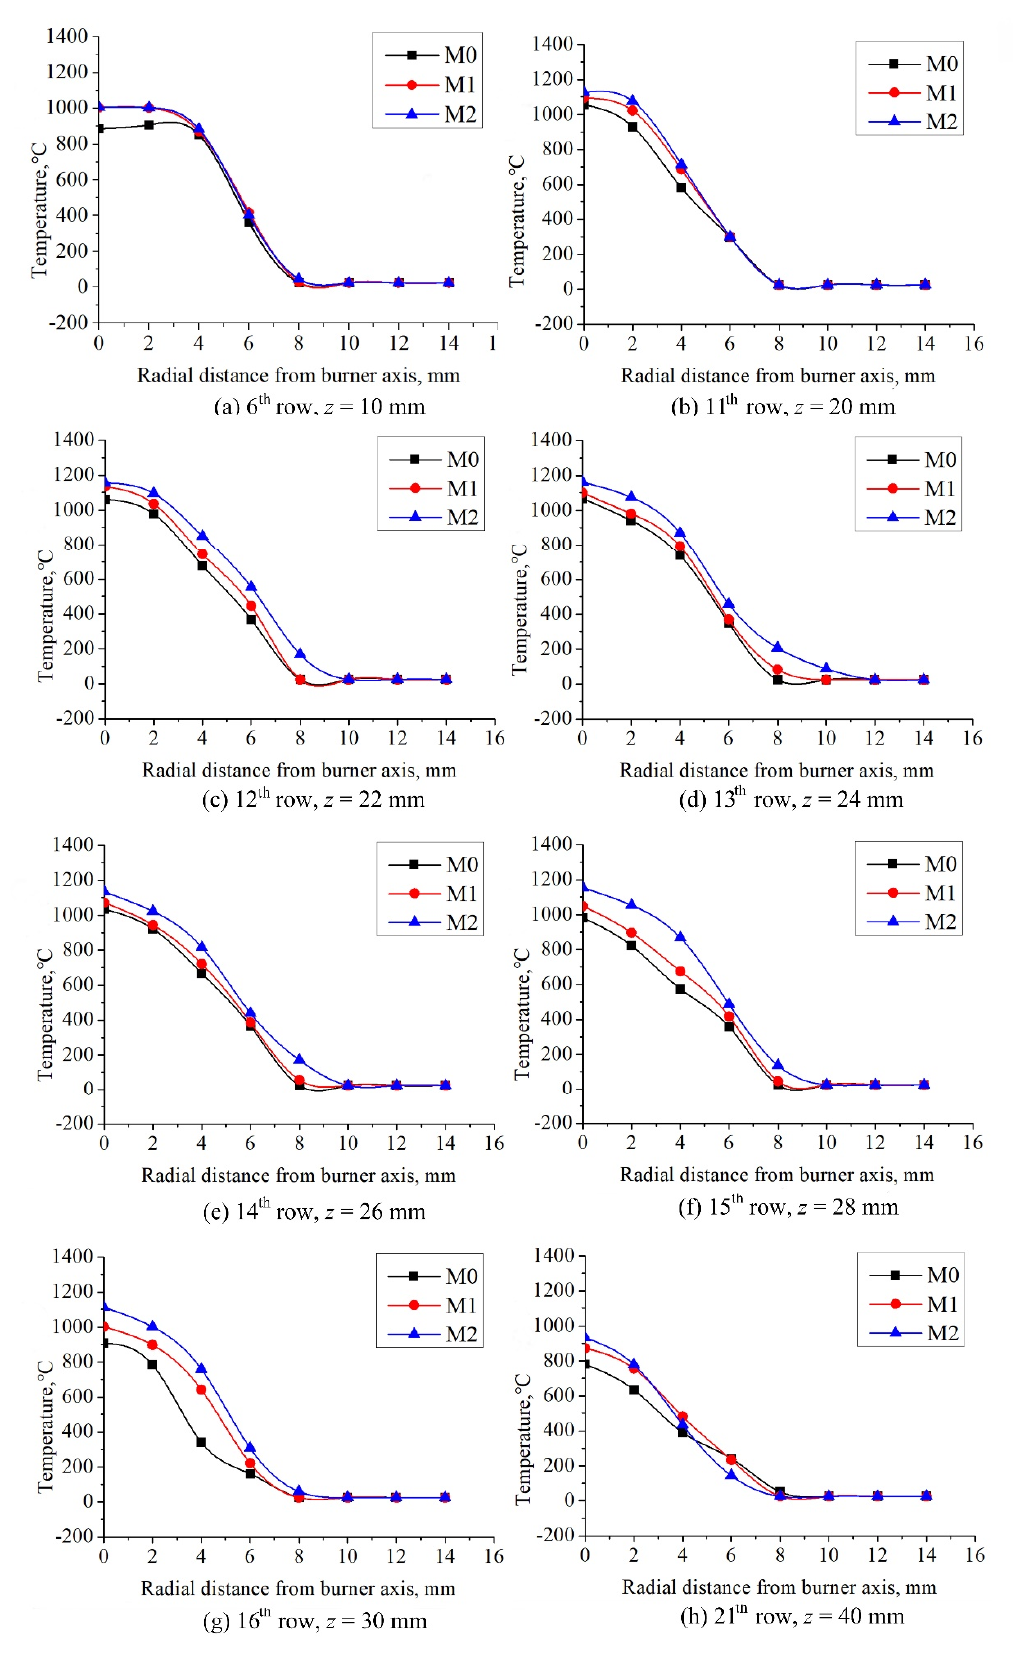
Figure 7. Radial temperature distributions at different elevations of diffusion flame at Re = 42.